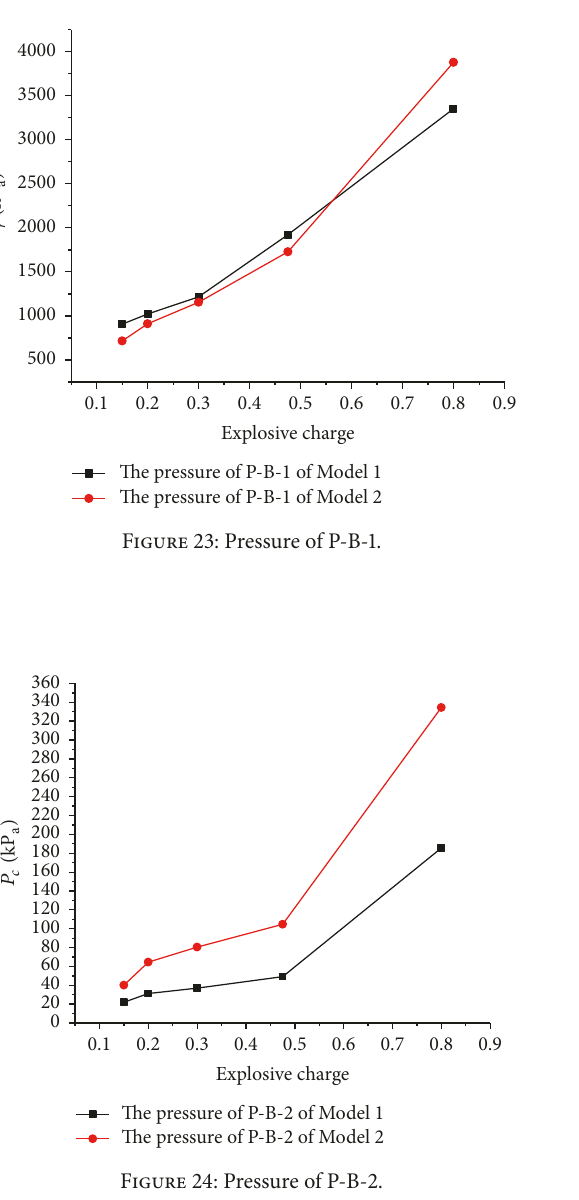
Figure 26: Pressure of P-C-2.